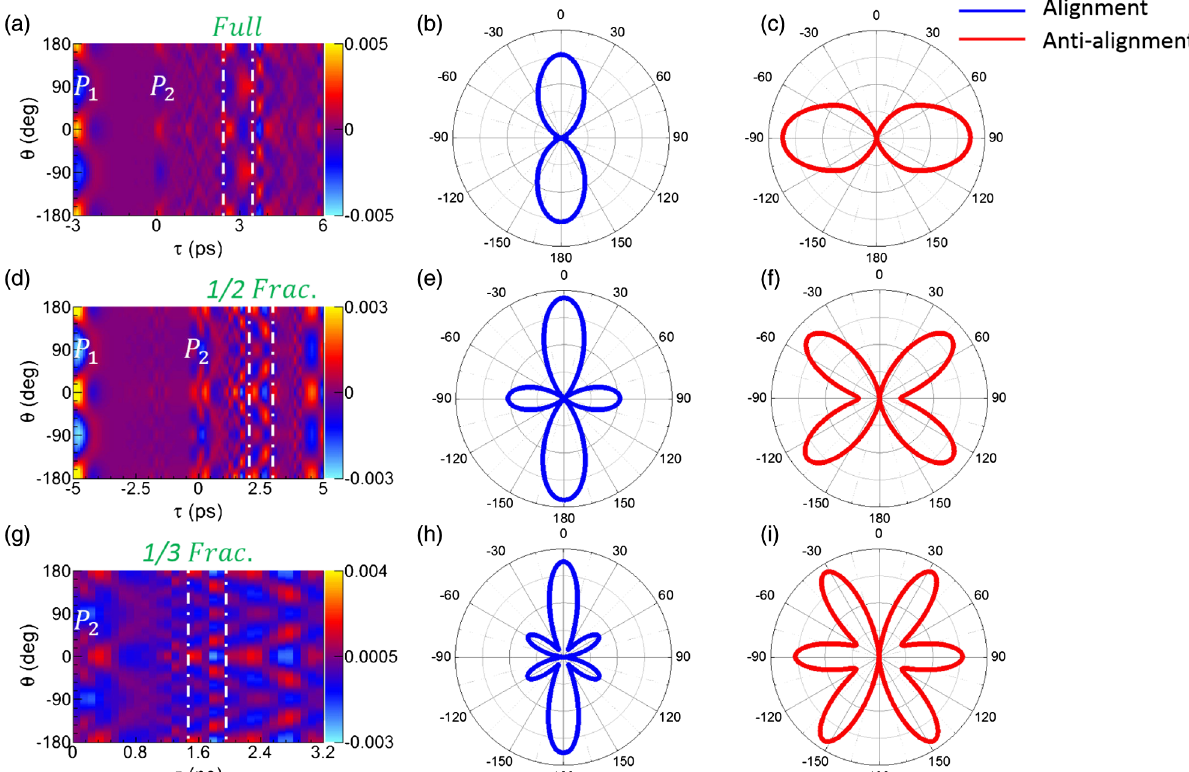
FIG. 9. Quantum simulation of time-dependent angular distributions of full, 1 = 2 , and 1 = 3 echoes. (a) Angular distribution of full echo in the case of a parallel condition with a time delay of 3 ps between P 1 and P 2 . (b,c) Alignment and anti-alignment of full echo in polar plots. Panels (d) – (f) and (g) – (i) show the same for 1 = 2 and 1 = 3 fractional echoes with a time delay of 5 ps between P 1 and P 2 ,